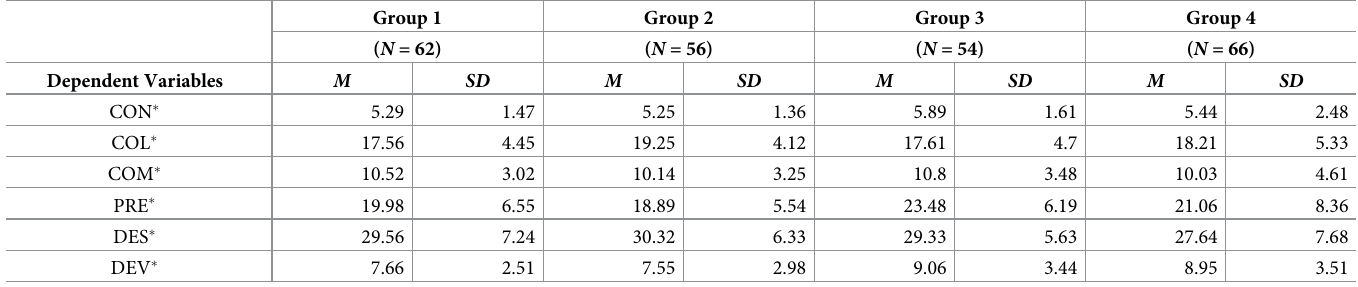
Table 2. Descriptive statistics for PE-TOBS